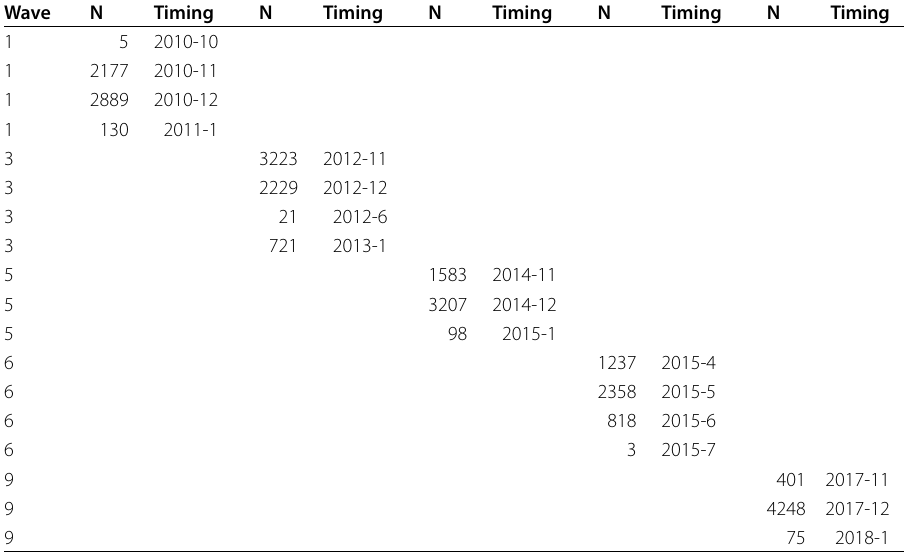
Table 2 Fieldwork for competence tests in NEPS SC3 by wave